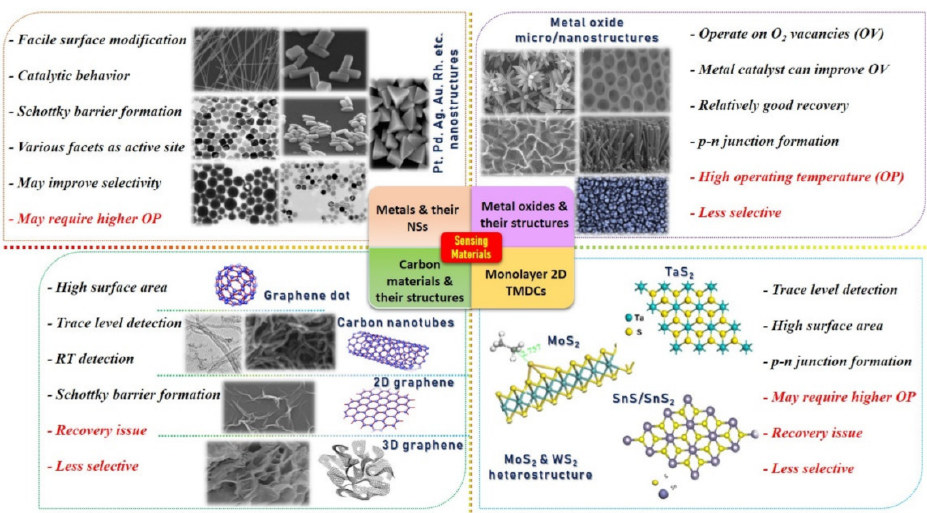
Figure 1. Different kinds of sensing materials with micro/nanostructures, their advantages (in black color), and limitations (in red color), indicating the need of hybridization/composition, dop- ing, and p–n junction formation. In particular, the figure suggests that the decoration/doping of metal/hetroatom over the base materials will enhance the catalytic reaction for specific gases and form the charge accumulation depletion region to improve the sensing performances. Repro- duced from multiple sources with permission from References [18,41,42,46,80–91]. Copyright